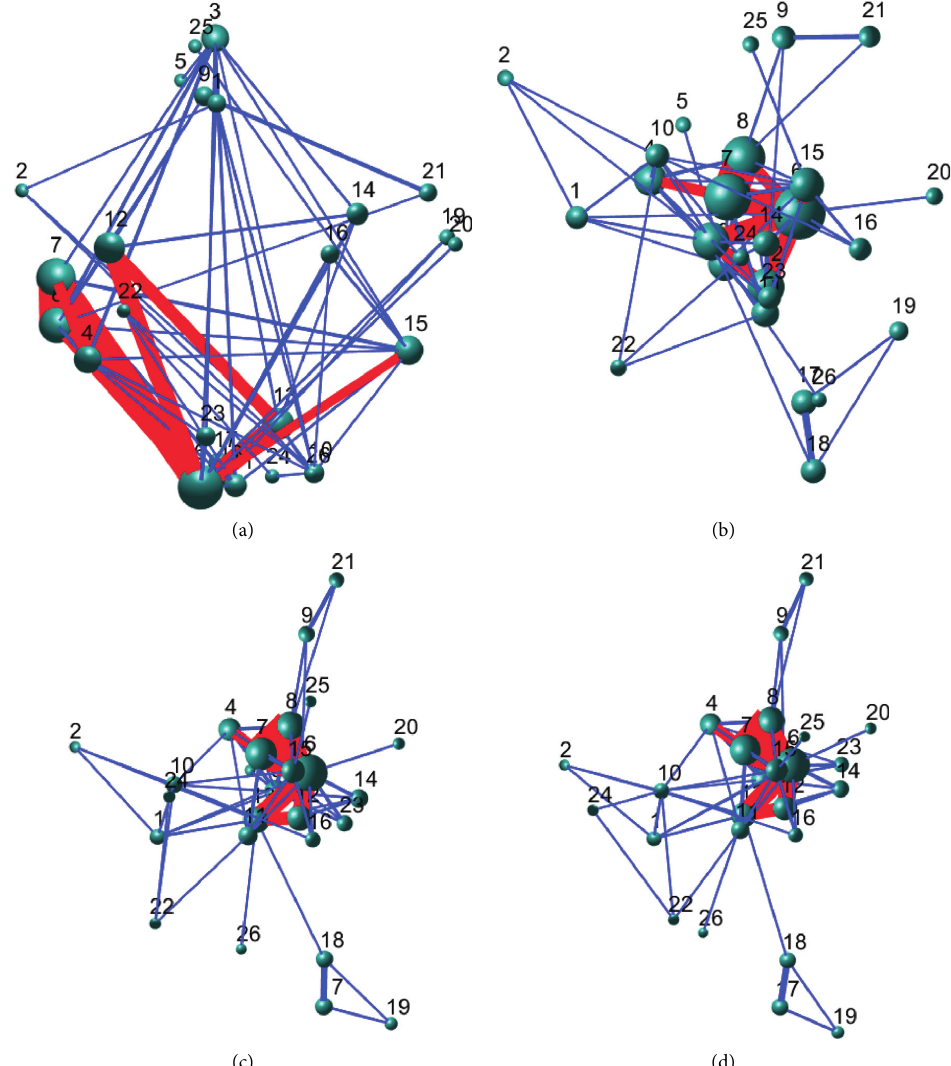
Figure 8: Snapshots of the process applying the proposed algorithm for “Romeo and Juliet.” (a) Initial state of 26 nodes at n � 0. (b) Intermediate state of nodes at n � 25. (c) Intermediate state of nodes at n � 310. (d) Equilibrium state of nodes at n � 617.